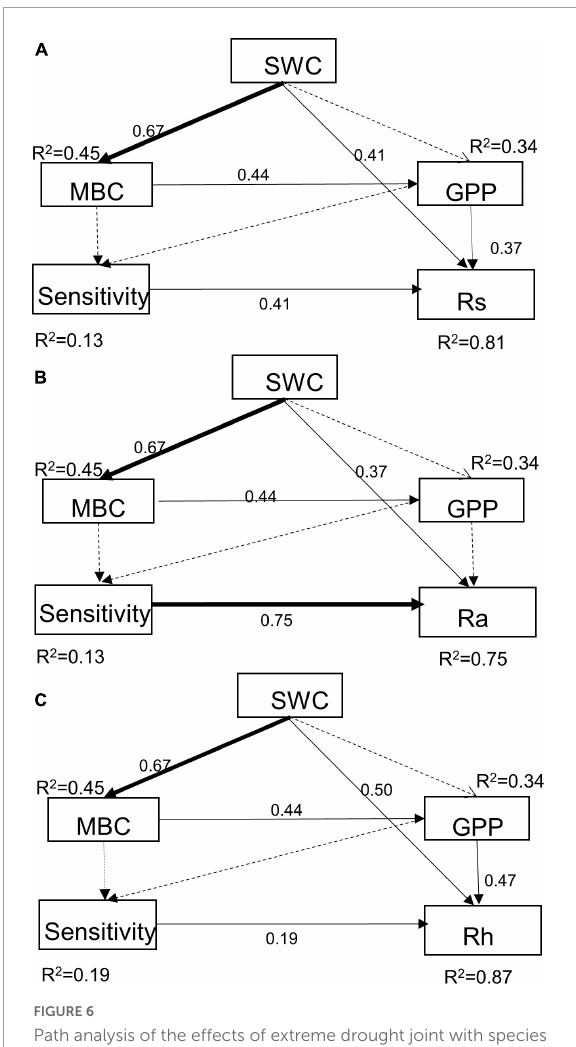
FIGURE6 Path analysis of the effects of extreme drought joint with species composition changes in abiotic and biotic factors on Rs (A) , Ra (B) , and Rh (C) . For Rs pathway, χ 2 = 0.43, P = 0.81, and df = 2, RMSEA < 0.01, AGFI = 0.99, CFI = 1.00; For Ra pathway, χ 2 = 1.42, P = 0.49, and df = 2, RMSEA < 0.01, AGFI = 0.98, CFI = 1.00; For Rh pathway, χ 2 = 1.87, P = 0.39, df = 2, RMSEA < 0.01, AGFI = 0.97, CFI = 1.00 (a high P- value associated with a χ 2 test indicates a good fit between the model and the data, i.e., no significant discrepancies). Solid and dashed arrows represent significant ( P ≤ 0.05) and non-significant relationships ( P > 0.05). Values associated with solid arrows represent standardized path